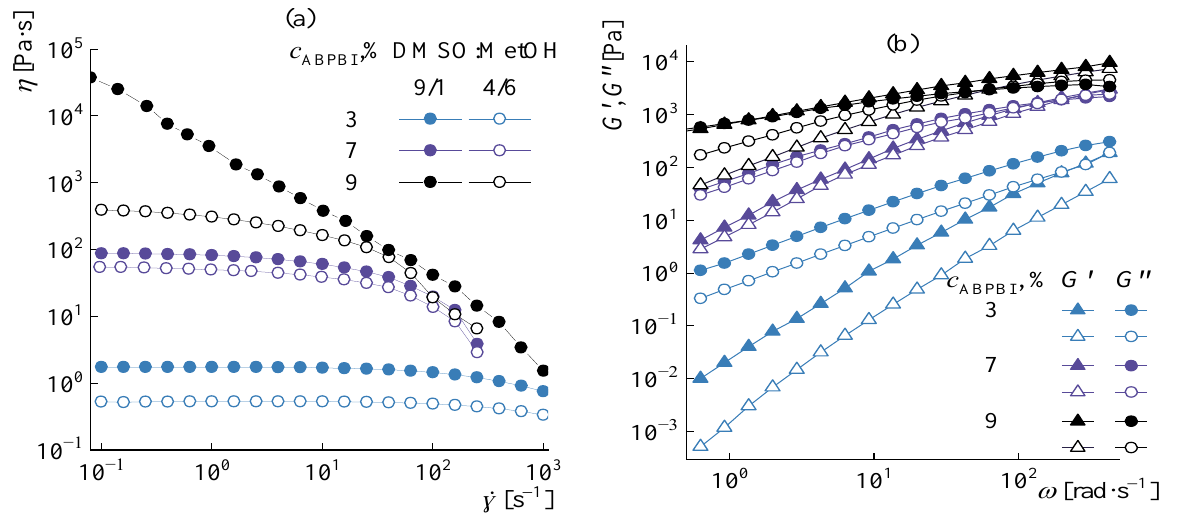
Figure 8. Dependences of viscosity on shear rate ( a ) and elastic and losses moduli on frequency ( b ) for ABPBI solutions. The data for the DMSO:MeOH ratio of 9:1 are shown as filled symbols, and for the ratio of 4:6 they are open.